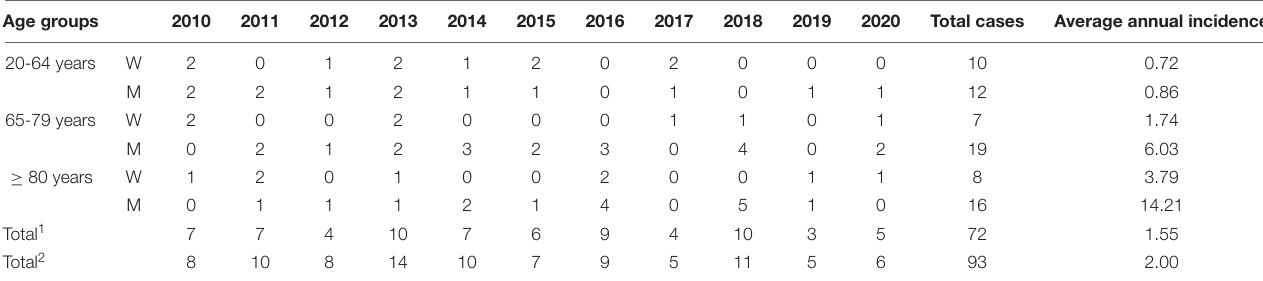
TABLE 1 | Annual distribution (number of cases) and incidence per 100,000 population of non-pregnancy-associated cases of human listeriosis in Gipuzkoa, north of Spain 2010–2020. Age